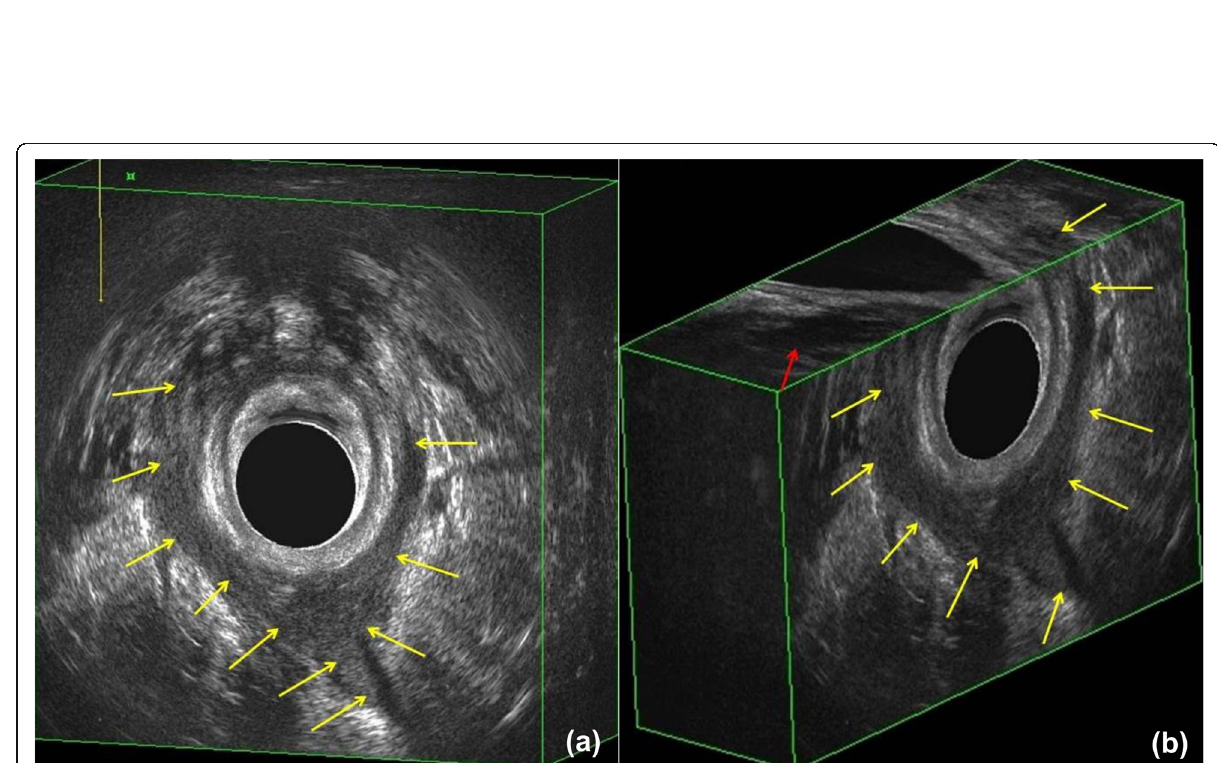
Fig. 9 3D TRUS image of a blind intersphincteric fistula (hypoechoic area marked by yellow arrows) at the upper anal canal level